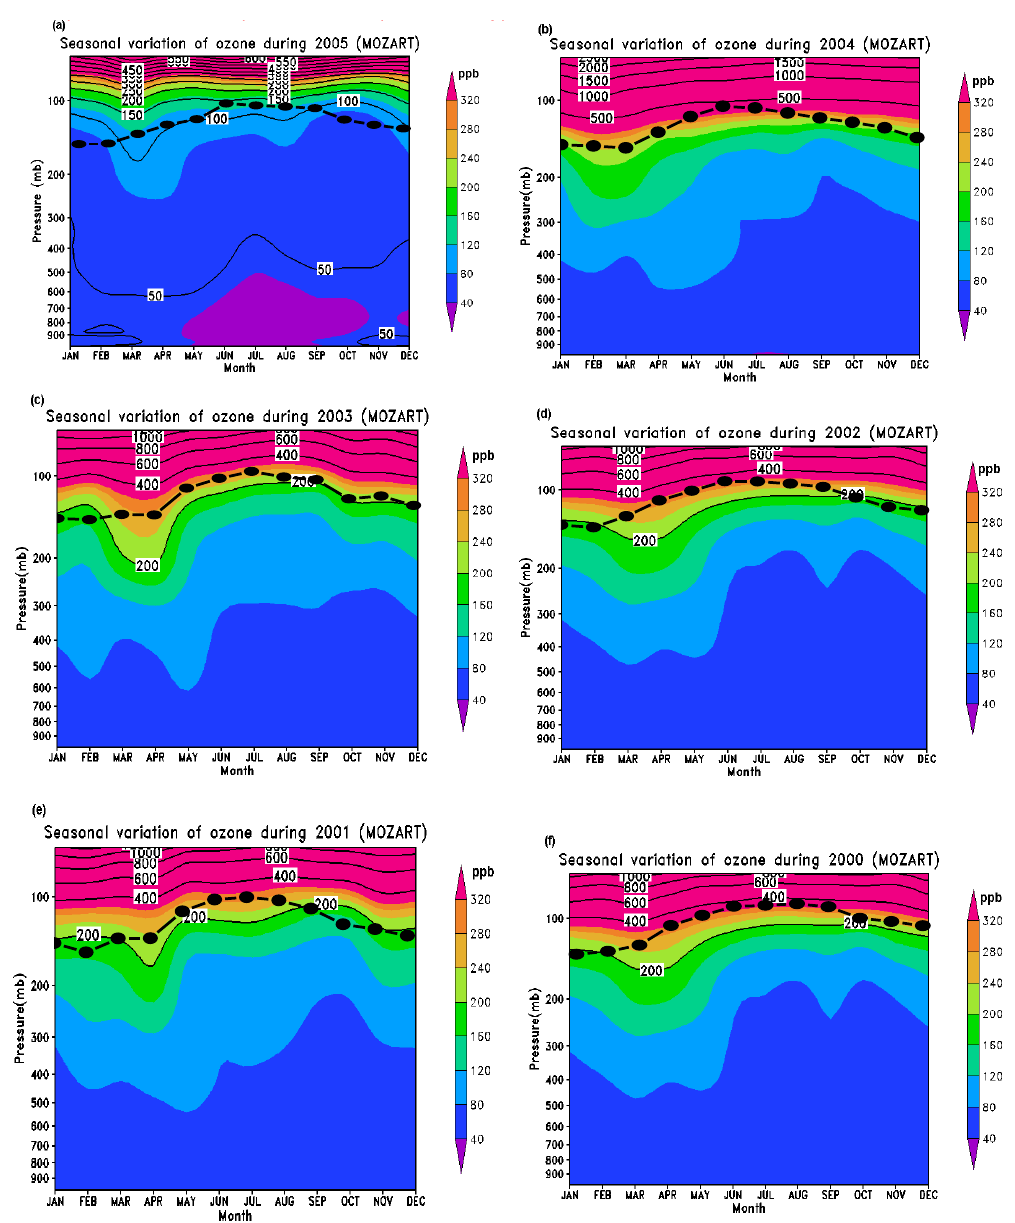
Fig. 4. Vertical variation of ozone mixing ratio (averaged over the Indian region) as obtained from analysis of MOZART model simulations for the years (a) 2005, (b) 2004, (c) 2003, (d) 2002, (e) 2001, (f) 2000. Thick black line with dots indicates tropopause